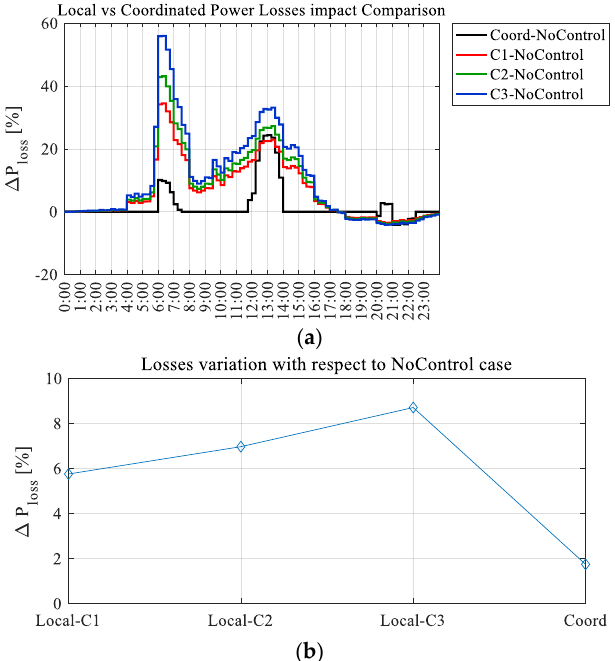
Figure 16. Local vs Coordinated Control real power losses: ( a ) profile; ( b ) aggregated. Figure 16. Local vs. Coordinated Control real power losses: ( a ) profile; ( b )